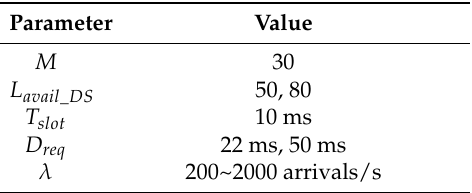
Table 1. Parameter used in model